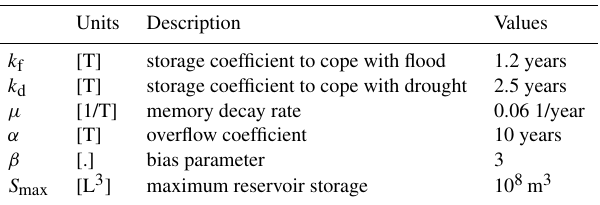
Table 2. Summary of time invariant parameters of the stylized model and value used in the experiment presented here.